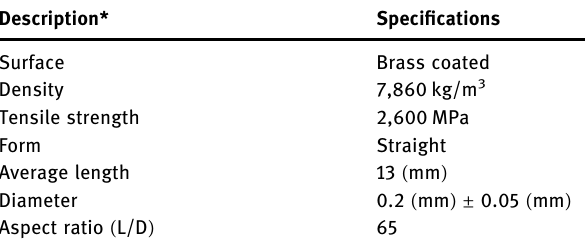
Table 1: Steel fi ber properties